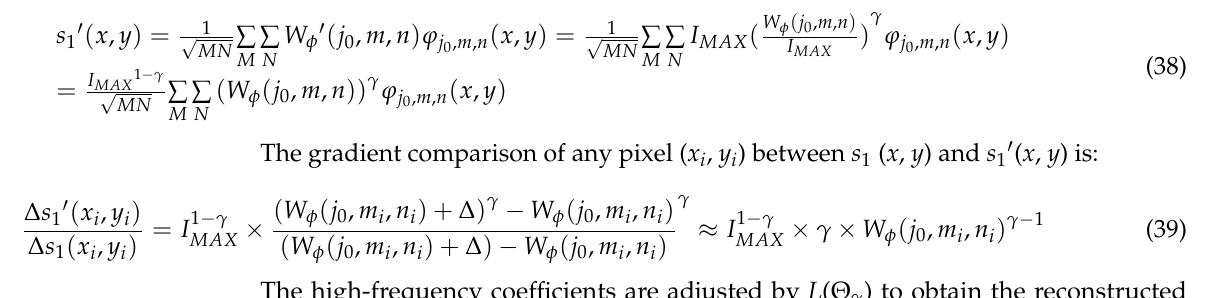
The high-frequency coefficients are adjusted by L ( Θ γ ) to obtain the reconstructed image s (cid:48) 2 ( x , y ): L ( Θ γ ) √ s 2 (cid:48) ( x , y ) = By substituting (39) and (40) into the edge smoothness preservation constraint (37), the punishment coefficient can be obtained: L ( Θ γ ) can adjust the high-frequency coefficient adaptively with γ ( Θ [ χ , σ ] ) to maintain the smoothness of the image edges. The HSV color model is used in our research because it is consistent with the human eye’s perception of color. It includes three characteristics: hue (H), saturation (S) and value (V). The V component represents the luminance intensity. GLAGC is performed on the V component. To restore the color information of the observed image, the output color